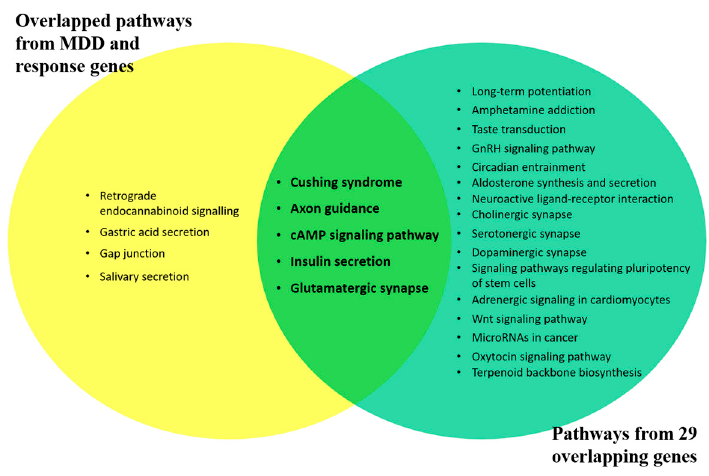
Figure 3. Top five pathways associated with an antidepressant response as well as MDD